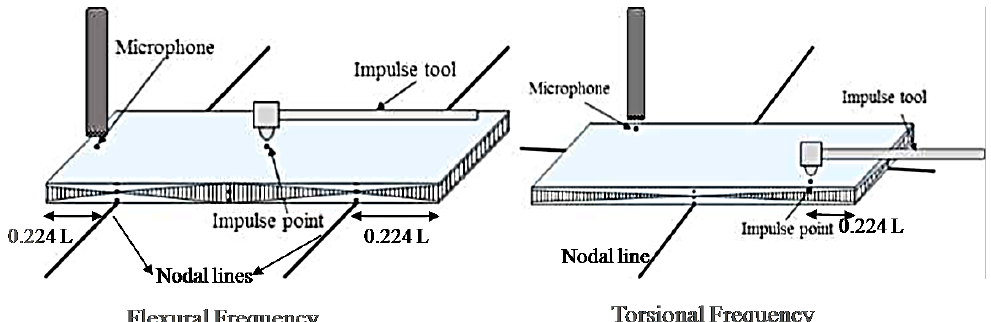
Figure 4. Schematic diagram of Impulse Excitation Technique (IET).